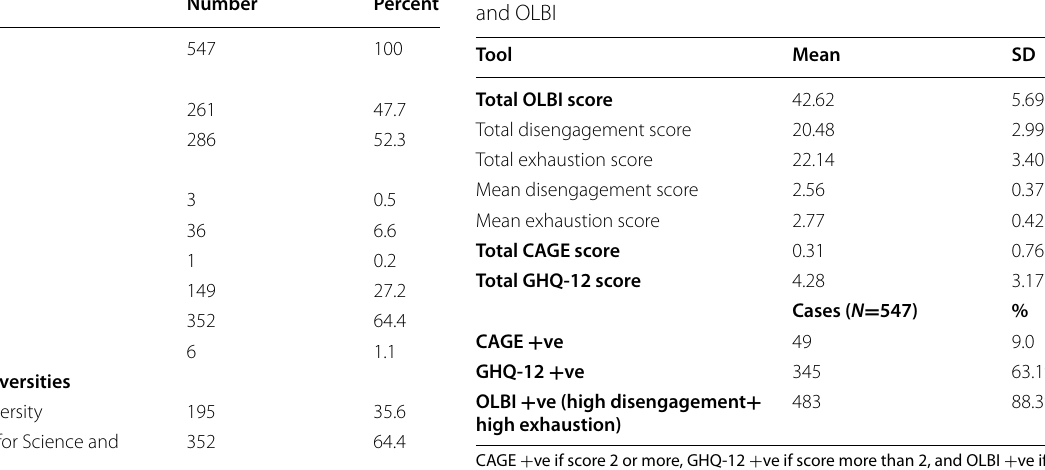
Table 2 Summary of results obtained from the CAGE,